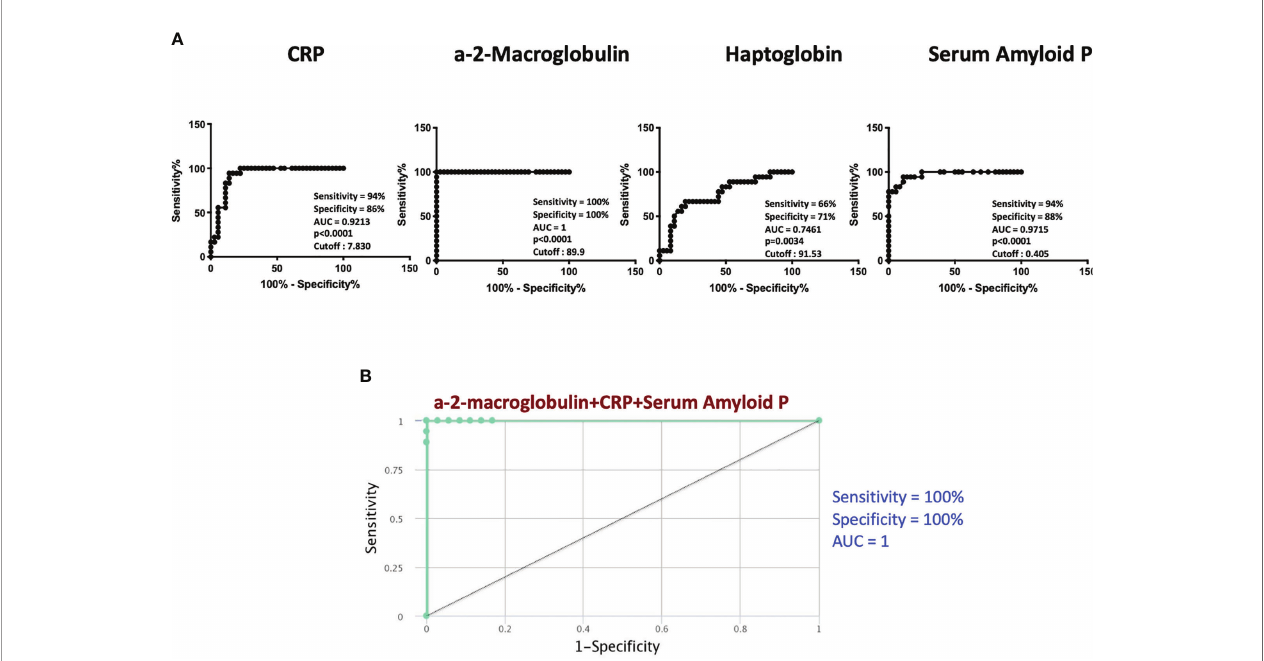
FIGURE 2 | ROC analysis to estimate the discriminatory power of APPs in TB treatment failure. (A) ROC analysis to estimate the sensitivity, speci fi city and AUC was performed using a-2M, CRP, Hp and SAP to estimate the capacity of these markers to distinguish individuals with failure vs . Cure. (B) Combination of ROC model analysis shows the APPs that exhibited the highest accuracy in discriminating failure and cure.